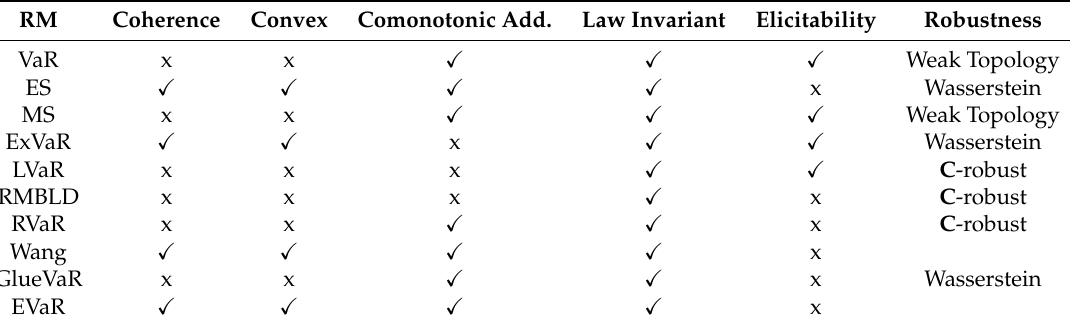
Table 1. Risk measures (RM) and basic